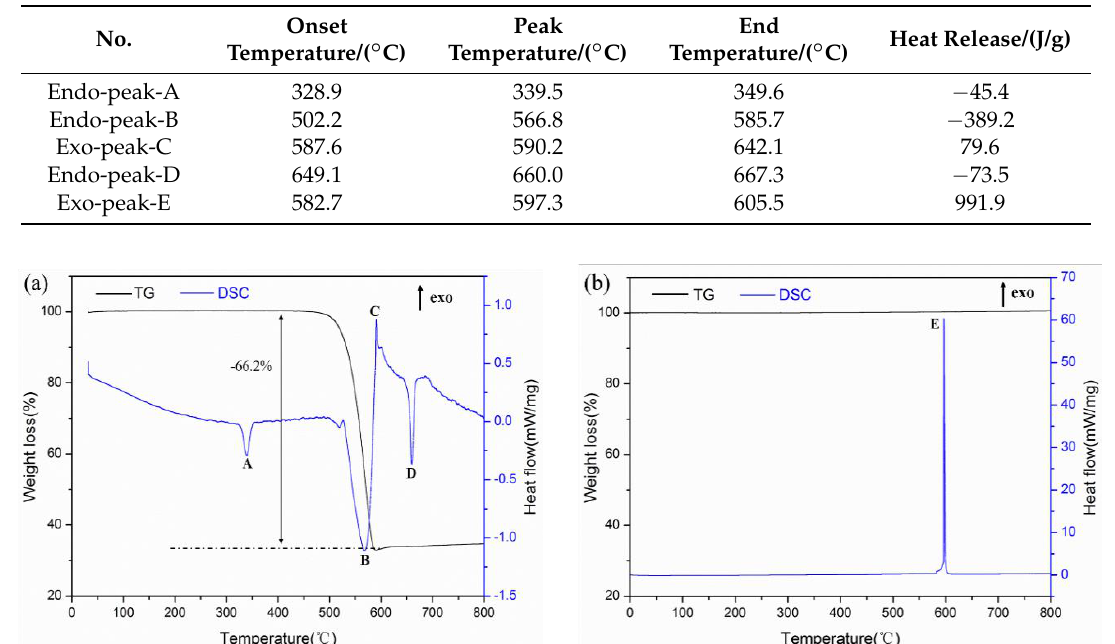
Table 2. The parameters for the endothermic and exothermic peaks in the DSC curves.